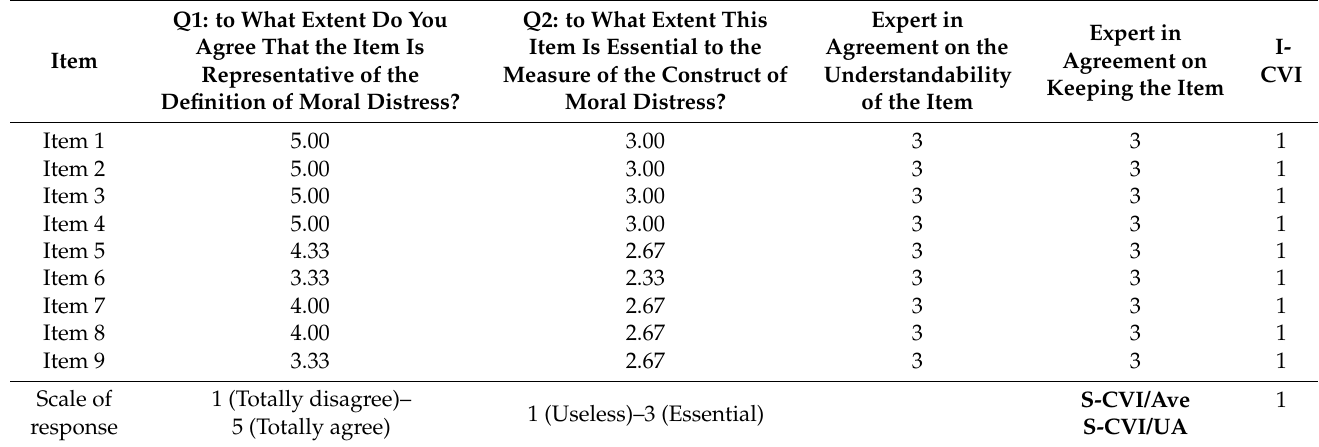
Table 2. Content validity indices regarding the three expert opinions.